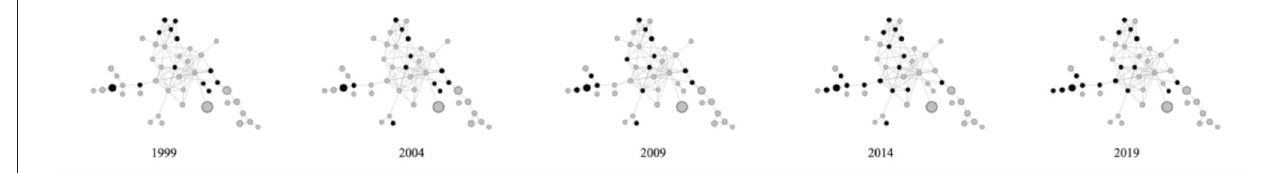
FIGURE 7 | Evolution of medical device product space in South